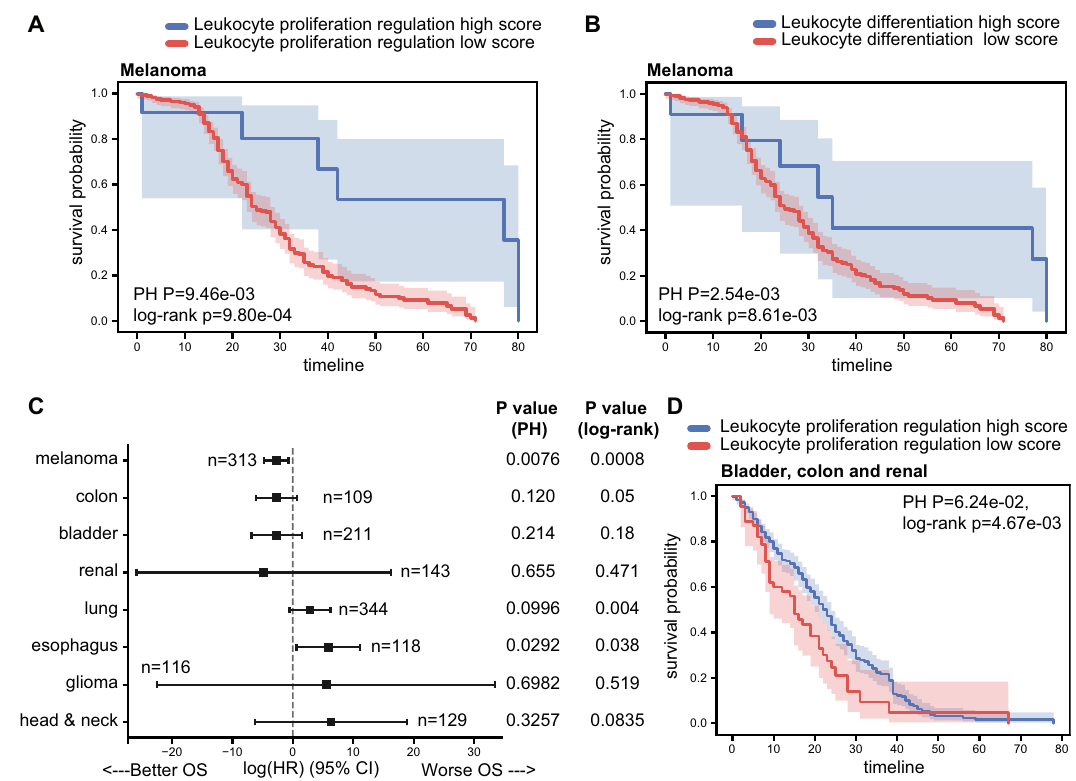
Fig. 3 | Mutations in leukocyte-proliferation and differentiation processes predict anti-PD1 overall survival. A Kaplan – Meier survival curves comparing between anti-PD1 treatedmelanoma patients with high vs low-prediction scores of the RF model, when trained using mutations within the leukocyte-proliferation regulation process. The Cox proportional hazards as well as the log-rank P values are indicated. B Kaplan – Meier survival curves comparing anti-PD1-treated mela- noma patients with high vs low number of selected mutations in the leukocyte differentiation process, using the genetic algorithm feature selection. The Cox proportionalhazardsaswellasthelog-rank P valuesareindicated. C Thecoef fi cient